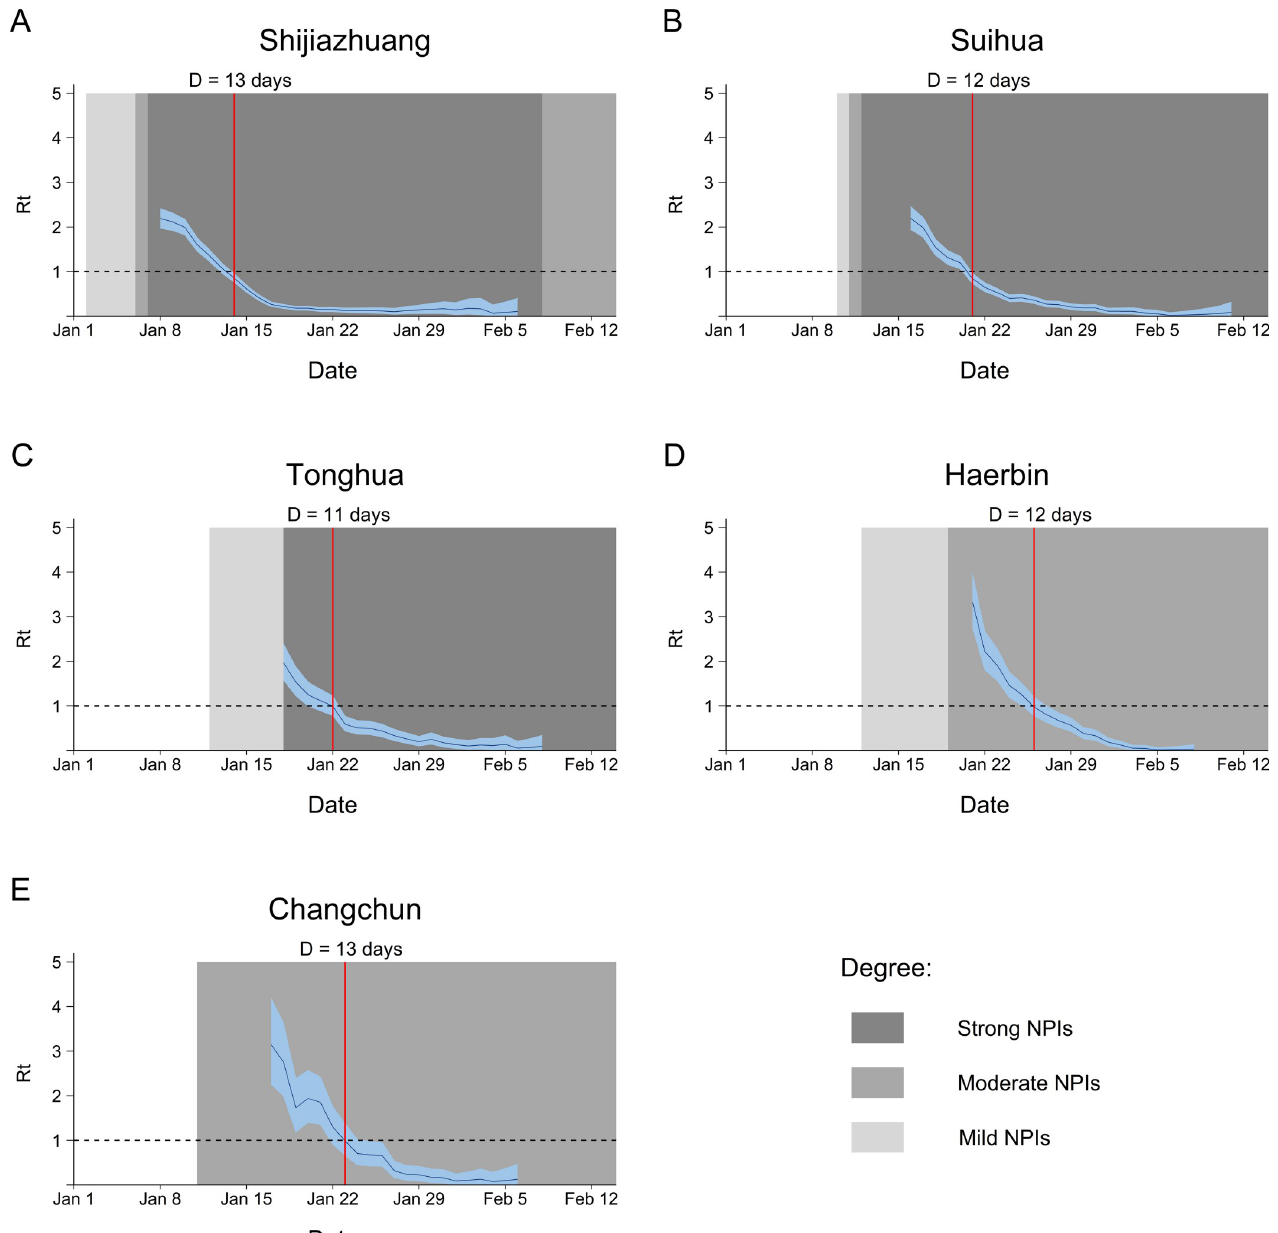
Fig 2. Temporal dynamics of SARS-CoV-2 transmission in five worst-hit cities in China, Jan-Feb 2021. The light, medium and dark grey regions show periods of mild, moderate and strong NPIs respectively. The red line represents the first day of R t < 1 in each city. D represents the days from the initial identification of local cases to R below the threshold. (A) Estimated R values from Jan 8 to Feb 6 in Shijiazhuang city. (B) From Jan 16 to Feb 11 in Suihua city. t t (C) From Jan 18 to Feb 8 in Tonghua city. (D) From Jan 21 to Feb 8 in Haerbin city. (E) From Jan 17 to Feb 6 in Changchun city. R t = time-varying reproduction